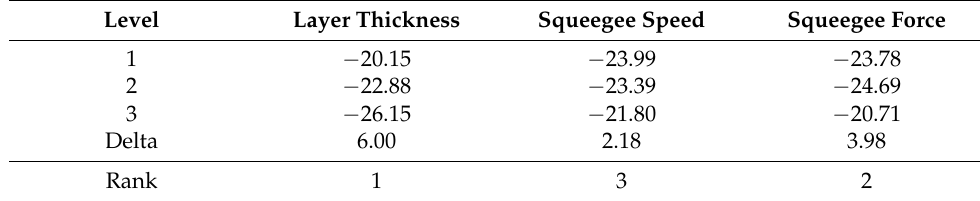
Table 4. Response table for S/N